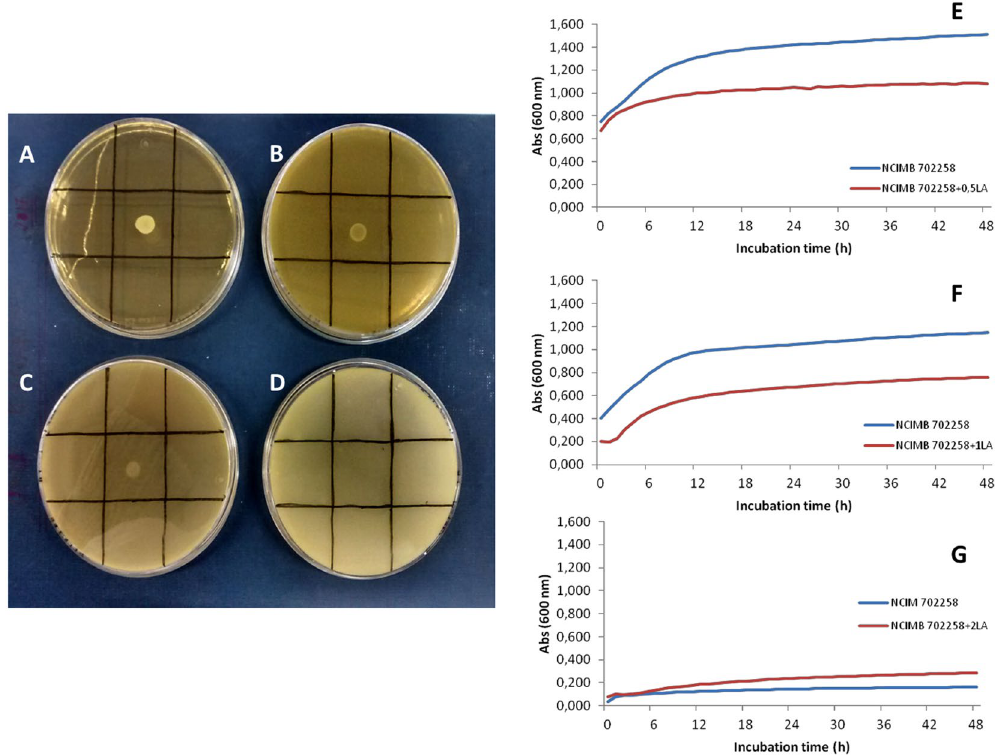
Figure 1. Substrate tolerance of B. breve NCIMB 702258 in cys-MRS agar plates containing 0 ( A ), 1 ( B ), 2 ( C ) and 5 mg/mL ( D ) of LA and growth curves in the presence of 0.5 ( E ), 1 ( F ) and 2 mg LA/mL ( G ) after 48 h incubation at 37 °C, under anaerobic conditions. Optical density was recorded at 600 nm. Results are expressed as mean and standard deviation (n =